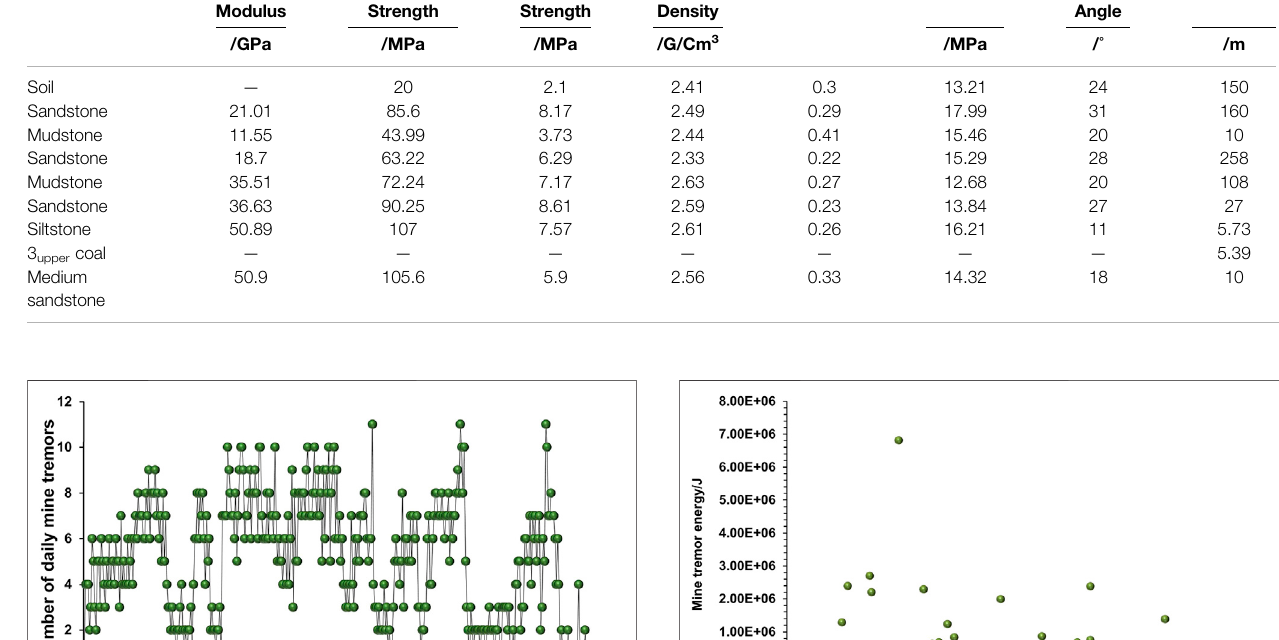
TABLE 1 | Main physical and mechanical parameters of the strata in No. 6 mining area. Lithology